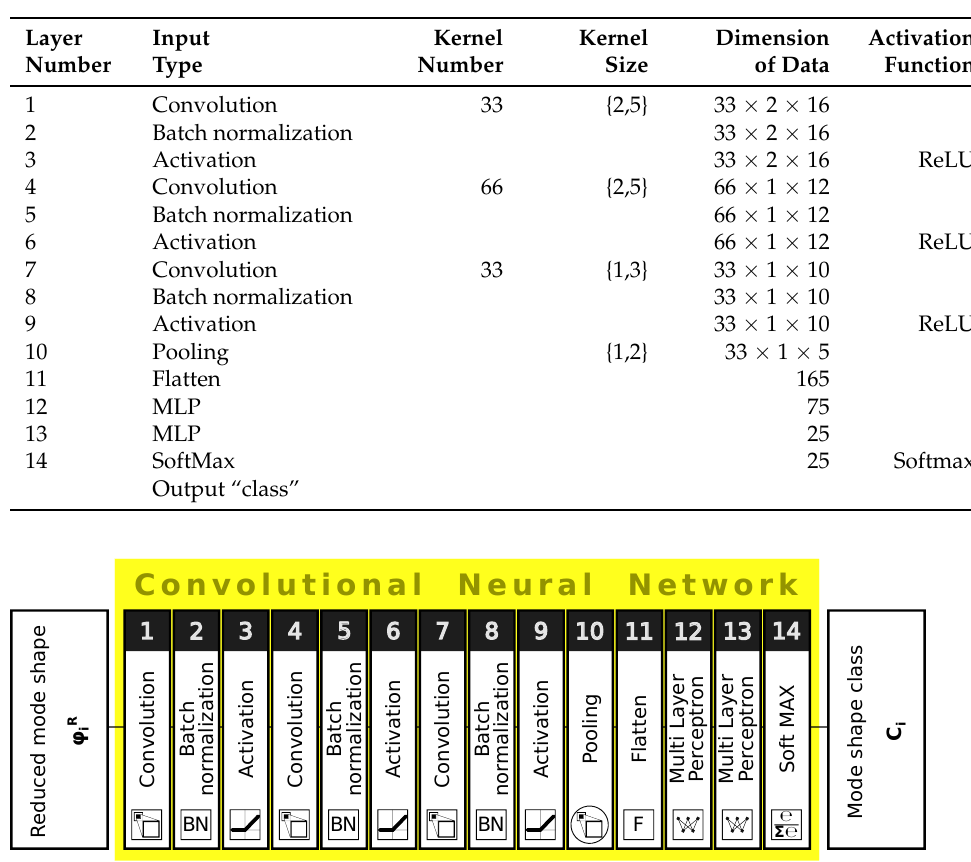
Table 1. The applied convolutional neural network (CNN) architecture (25 classes case).